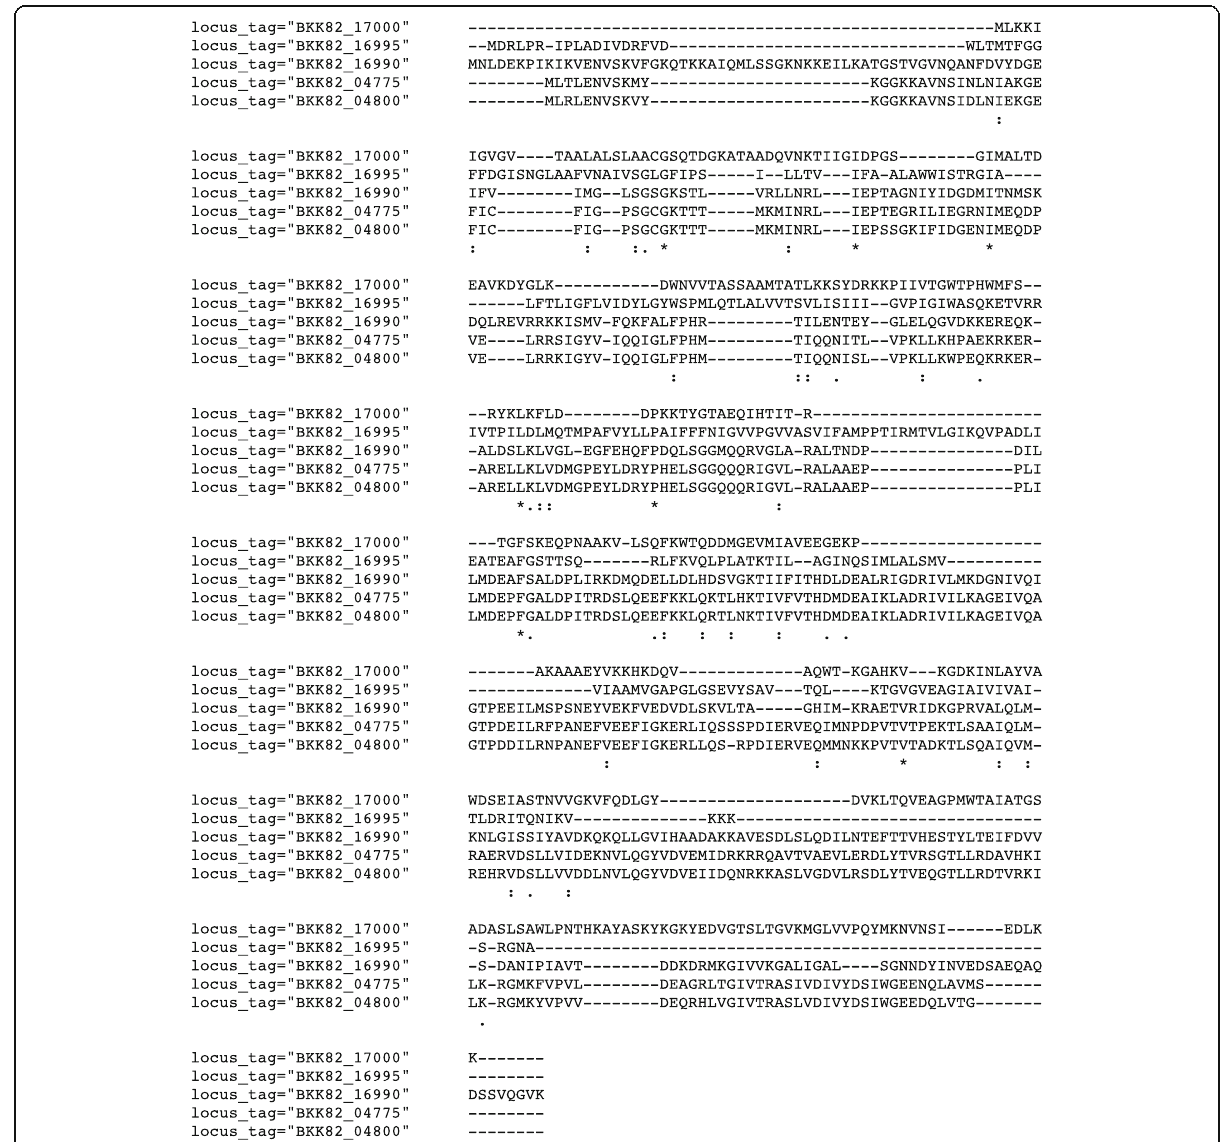
Fig. 4 Alignment of glycine betaine/L-proline ABC transporter proteins present in the genome of B. velezensis 2A-2B strain. Semiconservative and nonconservative amino acids